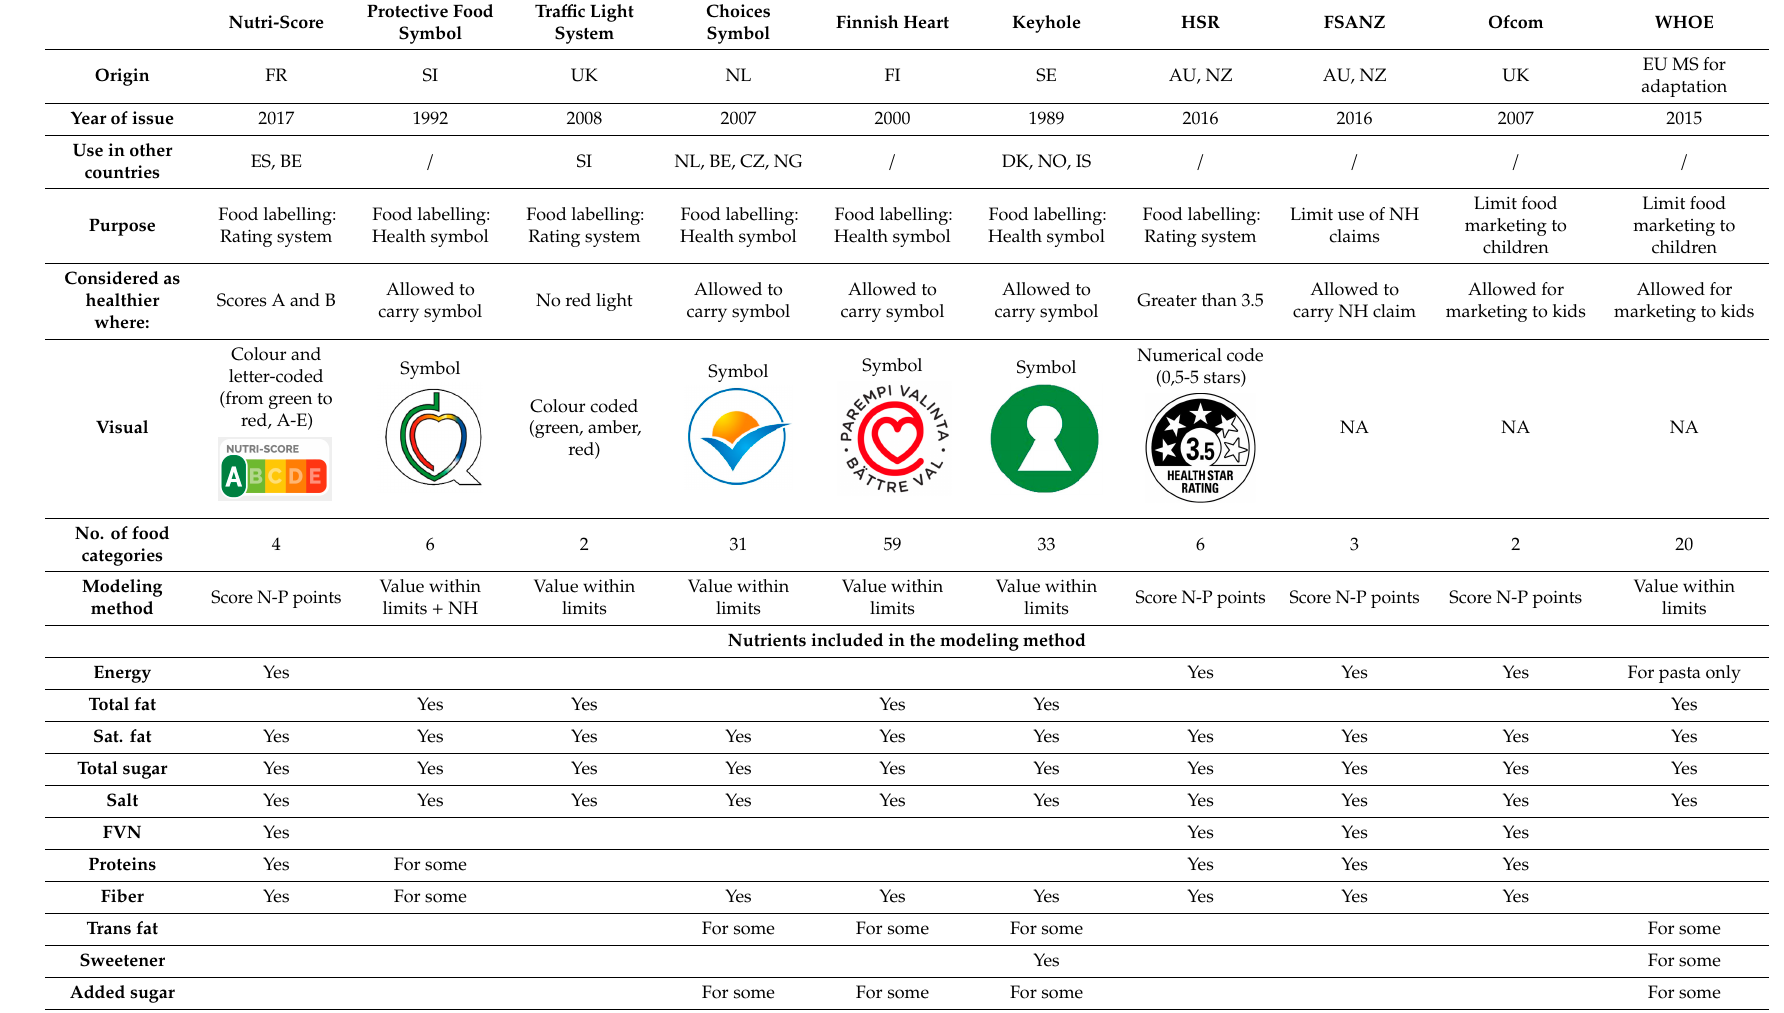
Table 1. Main properties for the used nutrient profiling models.